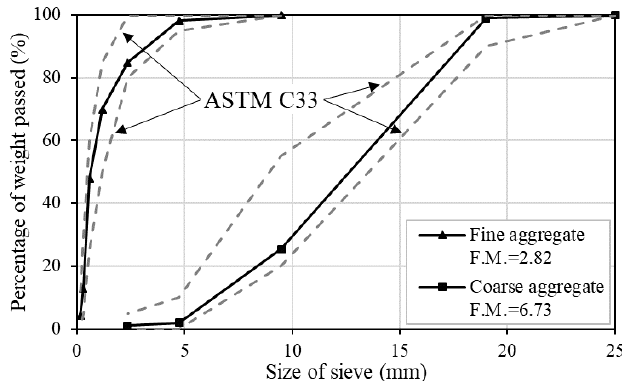
Figure 1. Sieve analysis of the aggregates.